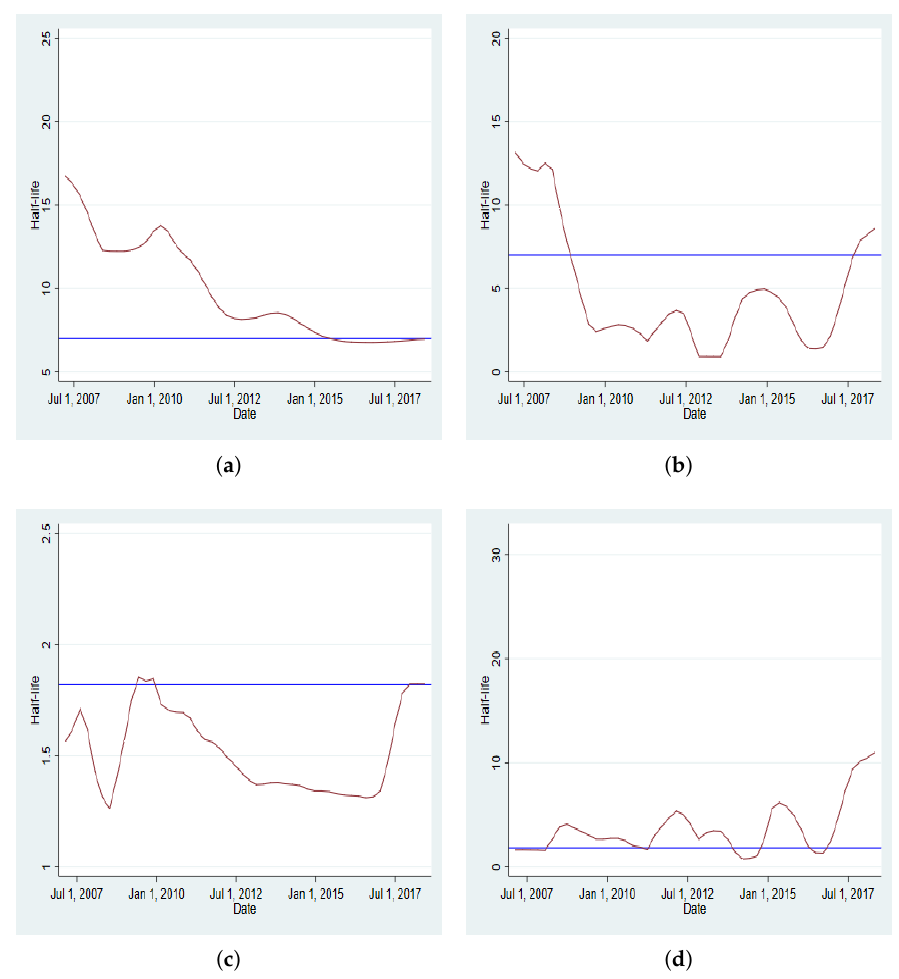
Figure 1. Dynamics of half-life for BRVM indices using rolling regression. These graphs plot the half-life estimated using rolling regression. The date is the end date for a selected window. In ( a ), the half-time is 14 days at the beginning using recursive rolling regression with a window whose end date is 1 July 2007. ( a ) Dynamics of the BRVMC half-time using recursive rolling regression with a 2-year window; ( b ) Dynamics of the BRVMC half-time using standard rolling regression with a 2-year window; ( c ) Dynamics of the BRVM10 half-time using recursive rolling regression with a 2-year window; ( d ) Dynamics of the BRVM10 half-time using standard rolling regression with a 2-year